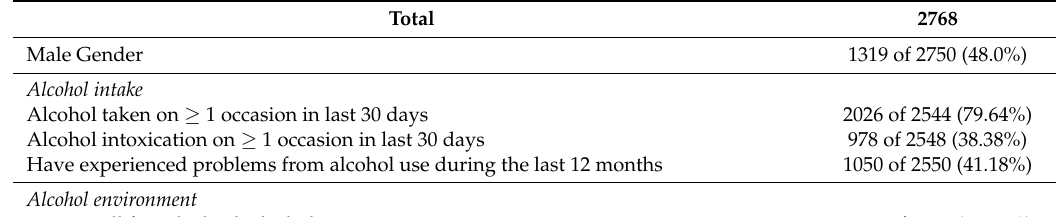
Table 1. Description of sample and variables of